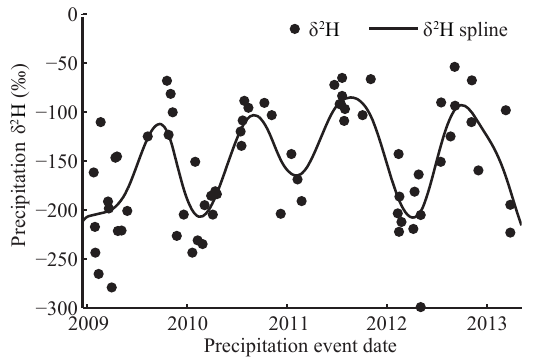
Figure 3. Measured δ 2 H in precipitation at Barrow, AK, exhibits variability on interannual, annual, and event time scales. The spline fit, which highlights seasonal variations, explains 65% of variance in the data with a root mean squared error of 39.7‰. Of the three timescales, annual variability shows the greatest amplitude, though variability among events is also substantial. Maximum enrichment corresponds roughly to the warmest months (June, July, and Au- gust), and maximum depletion corresponds roughly to the coldest months (December, January, and February).